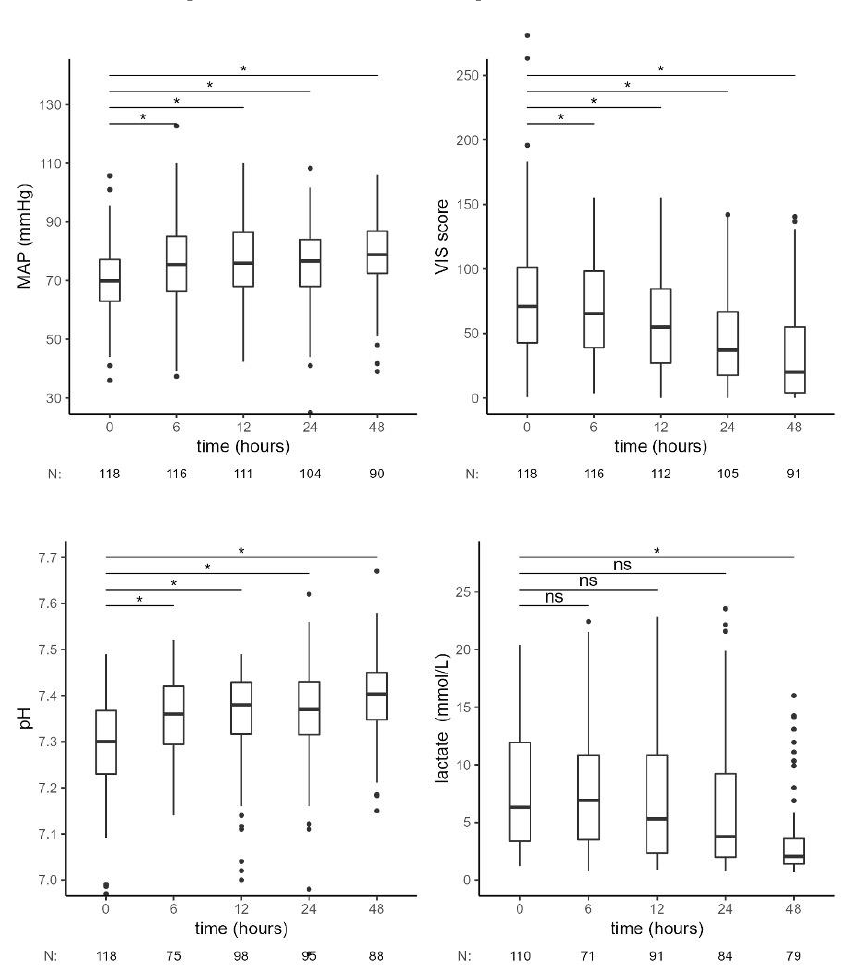
Figure 3. Hemodynamic and laboratory parameters from the beginning of CytoSorb treatment to 48 h after the start of the first CytoSorb treatment. Values presented as median, interquartile range, minimum and maximum; outliers and N of available measurements are shown. Comparison by paired Wilcoxon test. Values p < 0.012 were considered statistically significant and are indicated by *. MAP — mean arterial pressure, VIS — vasoactive-inotropic score, ns — not significant.